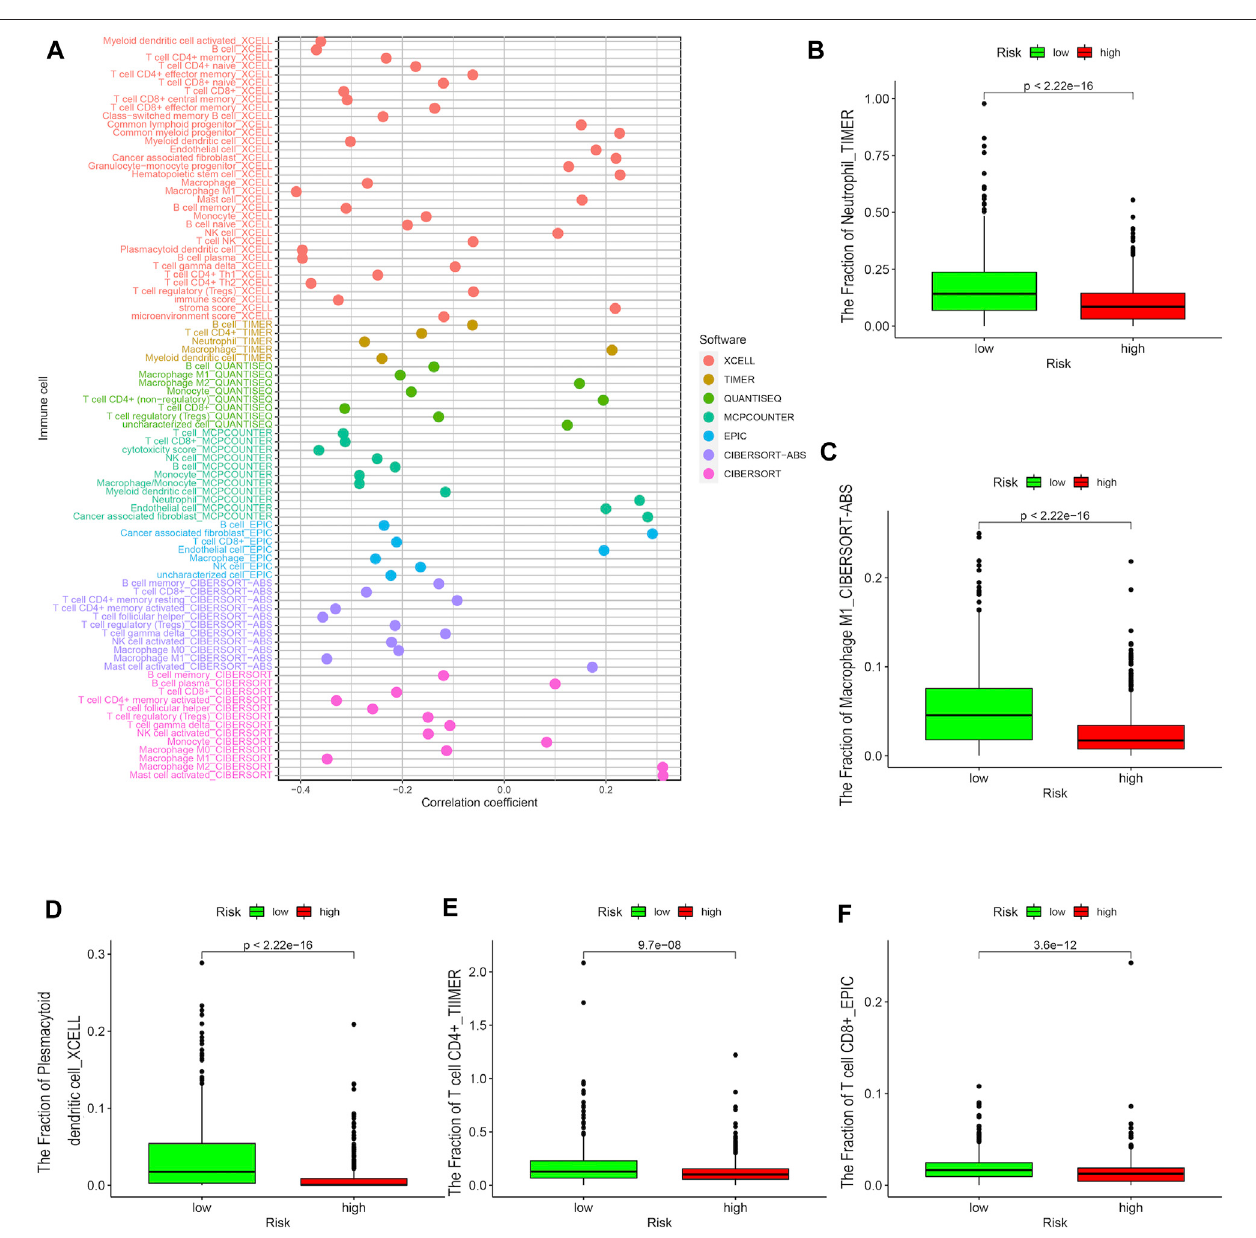
FIGURE3| Associationoftherisksignaturewithimmunecharacteristics. (A) TheWilcoxonsigned-ranktestwasperformedtoevaluatethecorrelationbetweenthe high-riskandlow-riskgroupsconcerningtumor-in fi ltratingimmunecells.Thehigh-riskgroupwasnegativelycorrelatedwiththefractionoftumor-in fi ltratingimmunecells, such as neutrophils (B) , M1 macrophages (C) , plasmacytoid dendritic cells (D) , CD4 + T cells (E) , and CD8 + T cells (F) .